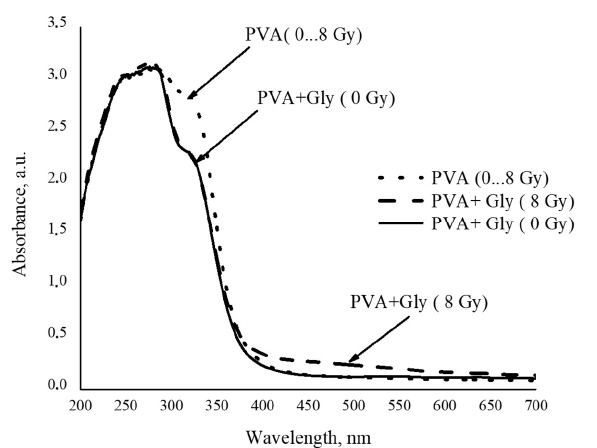
Figure 1. UV-VIS absorbance spectra of PVA and PVA + Gly samples before and after their irradiation with X-ray photons up to 8 Gy. Two absorption peaks at 279 nm and 322 nm wavelength corresponding to pure PVA